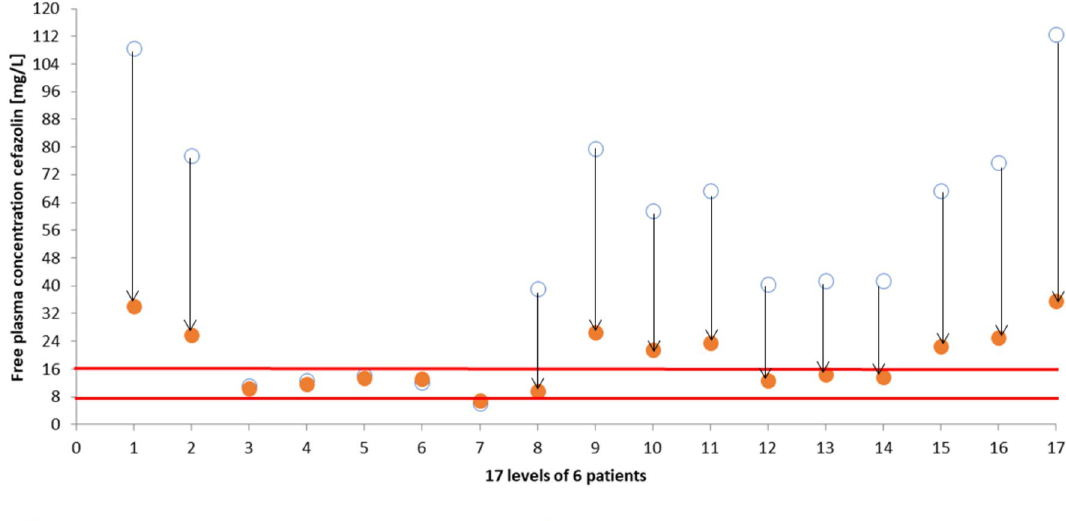
Figure 4. Effect of dosing software on unbound cefazolin concentration. By entering renal parameters and dialysis settings in a dosing software (thecaddy.de) 11 we received a recommended dose of cefazolin for each patient and each day. We were then able to calculate the hypothetical plasma concentration using the recommended dose and the measured cefazolin clearance of that day. This figure shows the actual measured free plasma concentrations of cefazolin (blue circles) using 6000 mg/d and the calculated concentration if we had used dosing software (orange circles). The y-axis shows the free plasma concentration of cefazolin in mg/L and the red lines show the target range of (unbound) cefazolin with 4 times and 8 times ECOFF (2